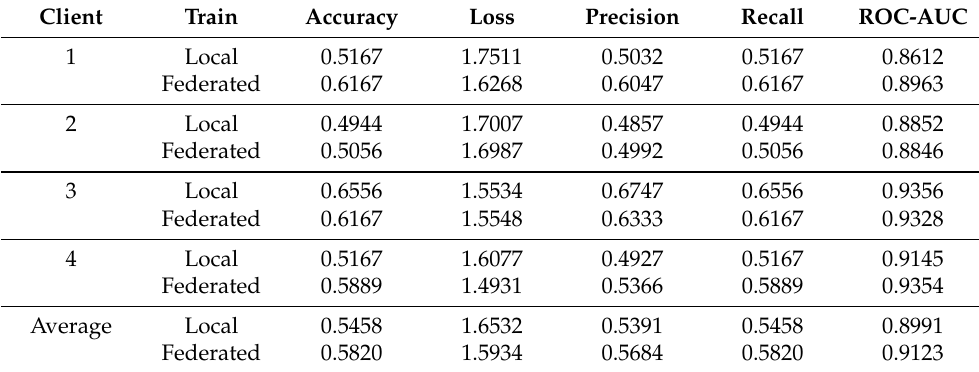
Table 4. Model training results for scenario 2.